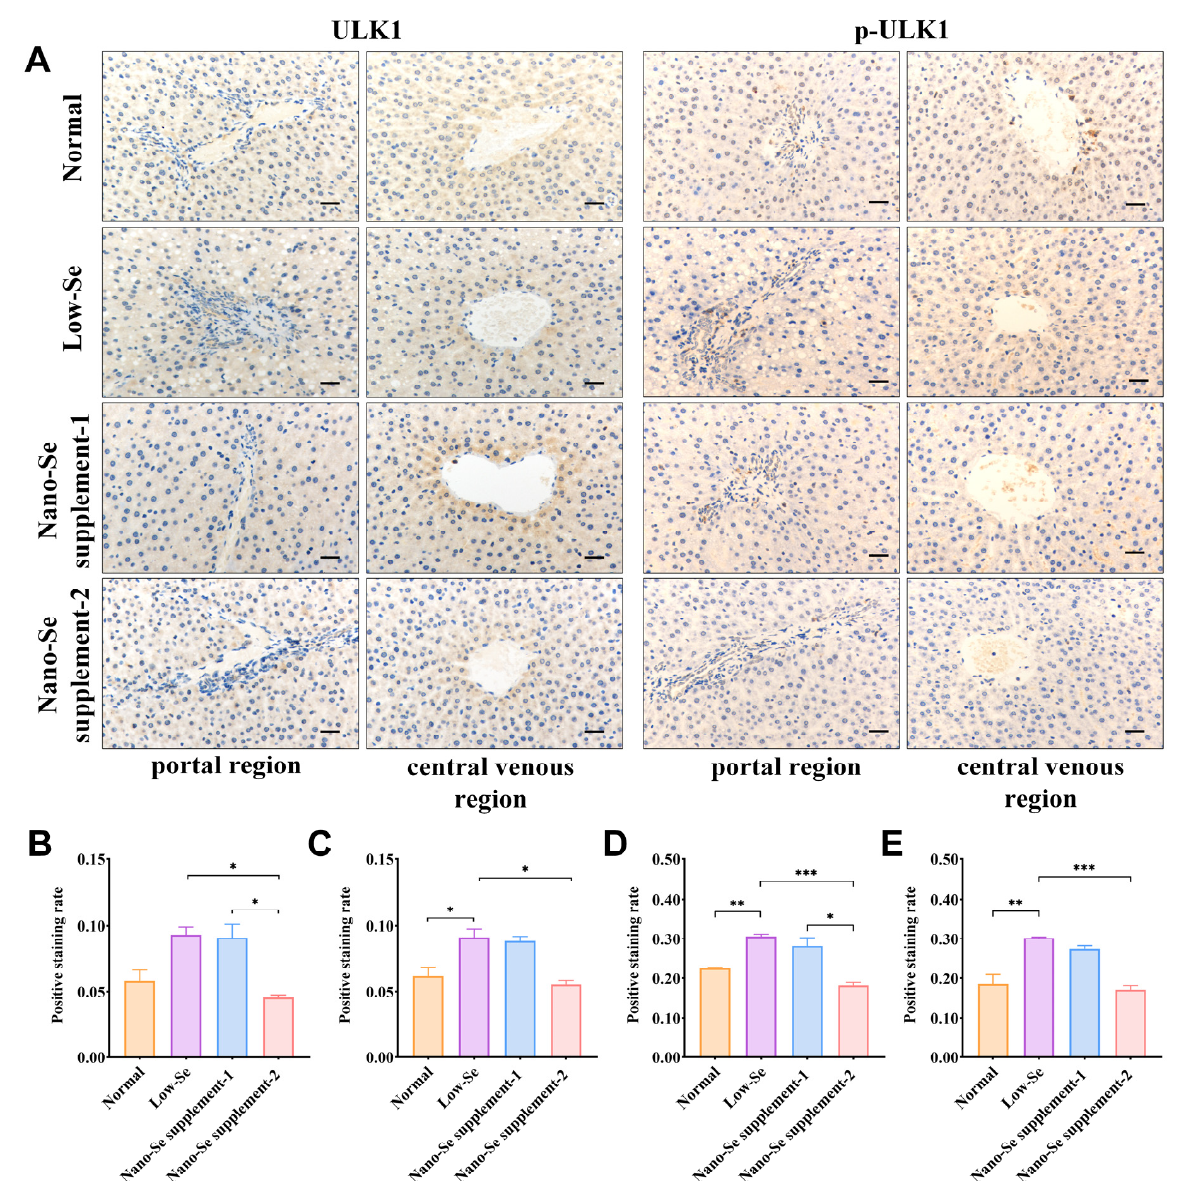
Figure 5. IHC staining results of ULK1 and p-ULK1 of livers in different groups. ( A ) Representative IHC staining of ULK1 and p-ULK1 in the portal and central venous regions. ( B , C ) The positive staining rates of ULK1 in the portal and central venous regions. ( D , E ) The positive staining rates of p-ULK1 in the portal and central venous regions. Scale bar: 200 µ m. * p < 0.05, ** p < 0.01, *** p < 0.001. Se: selenium; ULK1: unc-51 like autophagy activating kinase 1; p-ULK1: Phosphorylation-modified